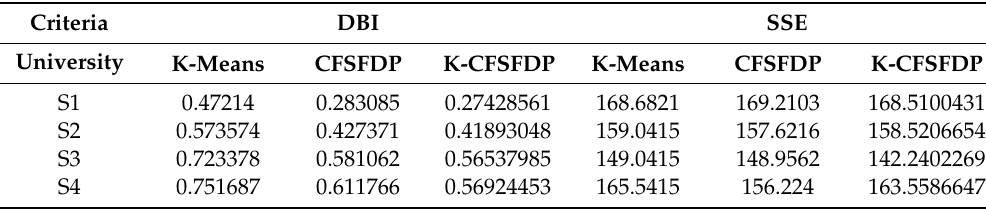
Table 7. Davies–Bouldin index (DBI) and sum of the squared errors (SSE) value of the three algorithms.